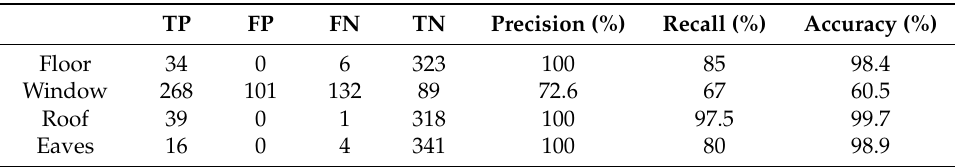
Table 10. Evaluation of semantic recognition for